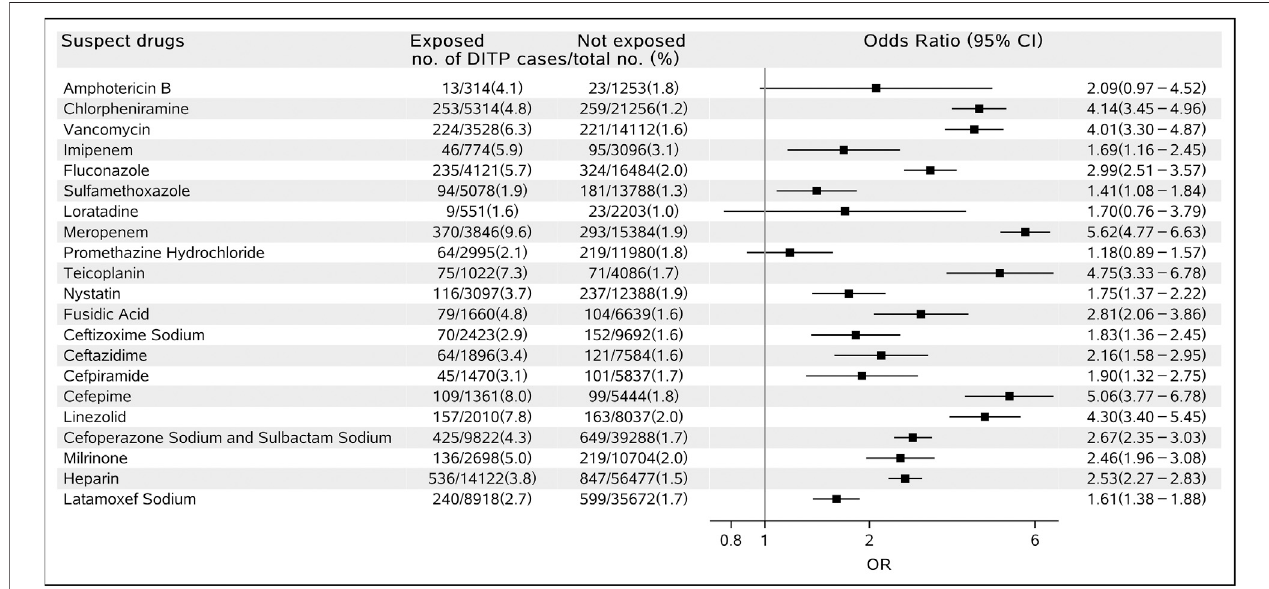
FIGURE 2 | Forest plot for the association of suspected drugs and DITP.